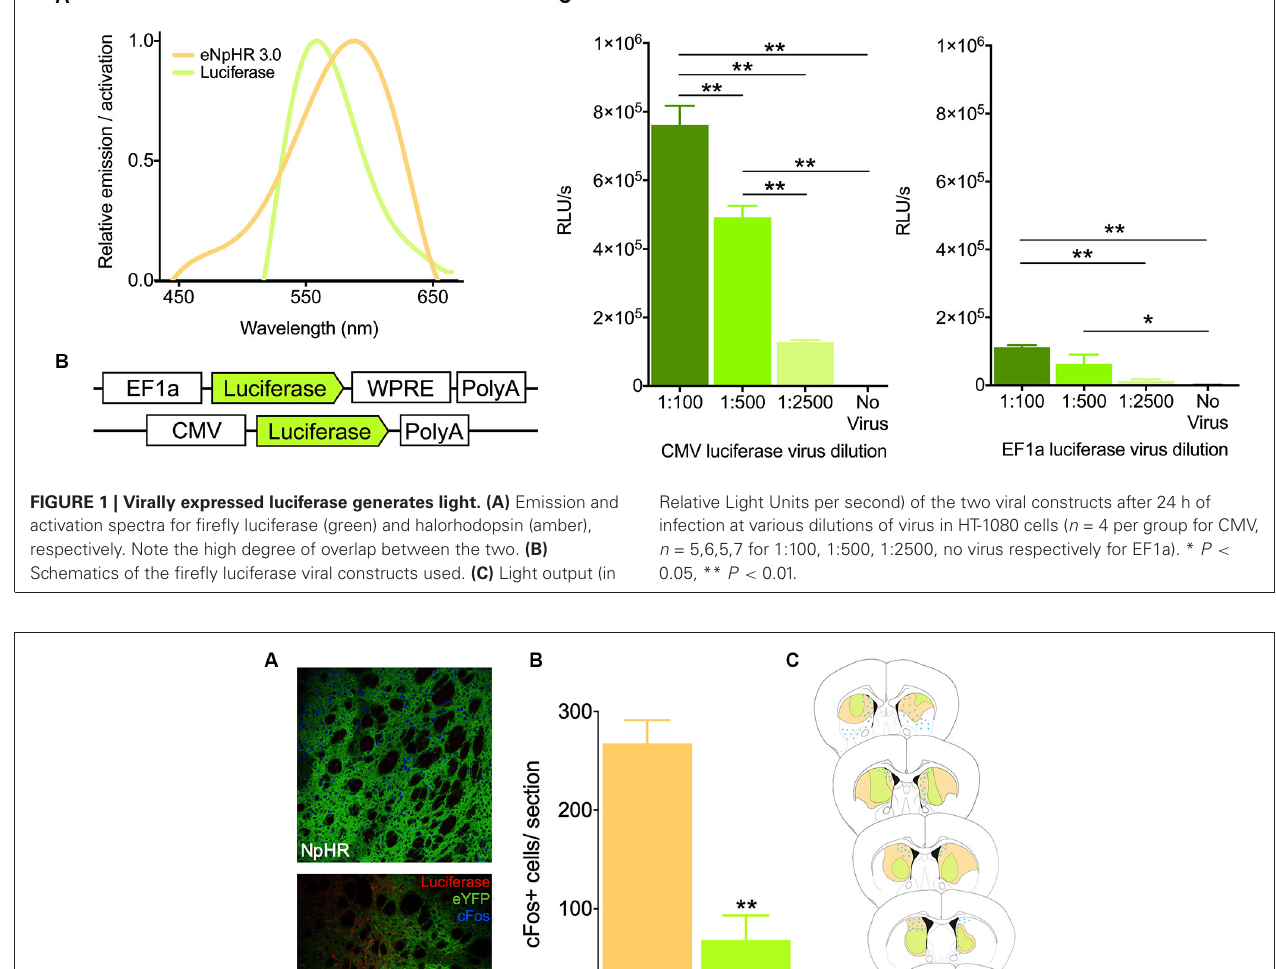
halo only animals 90 min after PTZ injection ( n = 6 striatal samples from four animals). (C) Schematic drawing of the rostro-caudal distribution of luciferase, halorhodopsin, and cFos in one animal. Note that in general, there is very little cFos immunofluorescence where both luciferase and halorhodopsin are expressed. ** P <